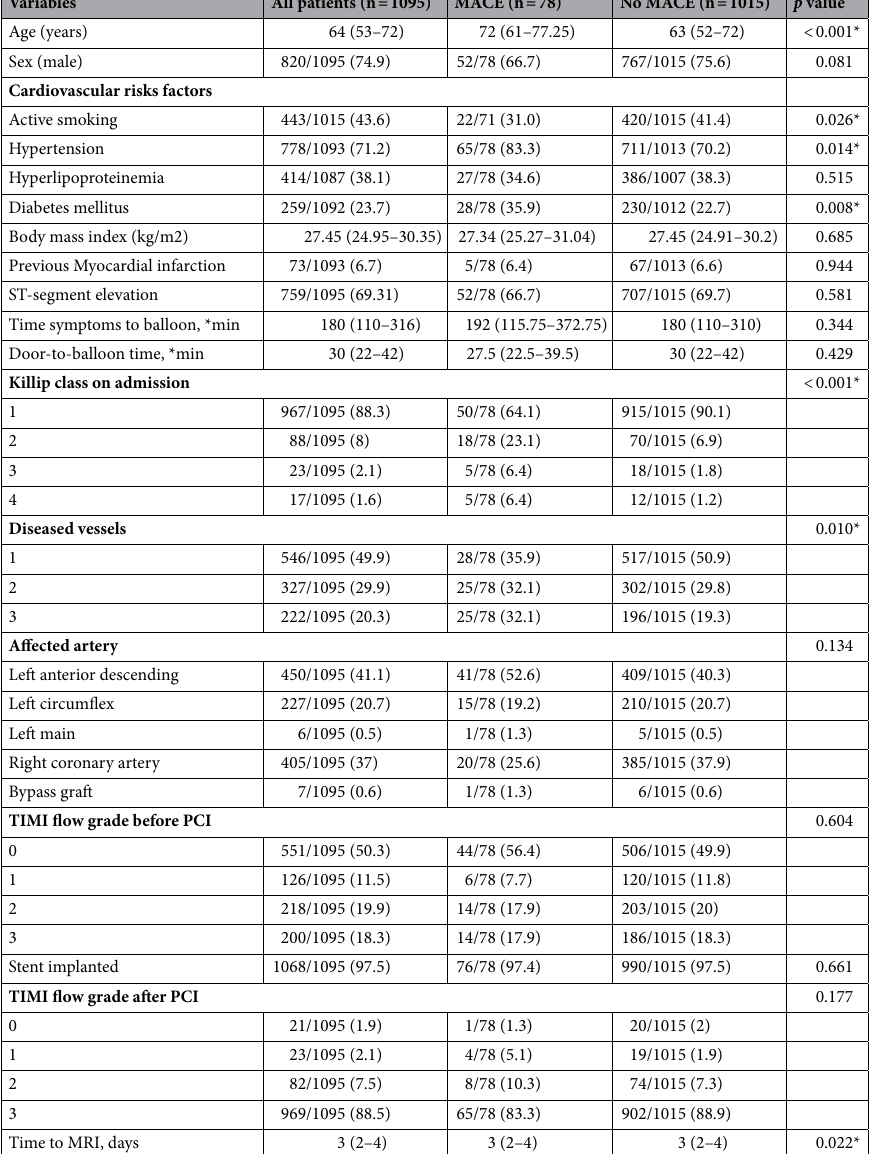
Table 1. Baseline characteristics. Patient data are represented either by n/N (%) or median (interquartile range). P values compare the variables with the occurrence of MACE. Two patients were lost to follow up (MACE). PCI, Percutaneous coronary intervention; MACE, major adverse cardiac event; TIMI, Thrombolysis in myocardial infarction. *Indicates statistical significance. Mann–Whitney U test was performed for continuous variables and Chi-square test was performed for categorical